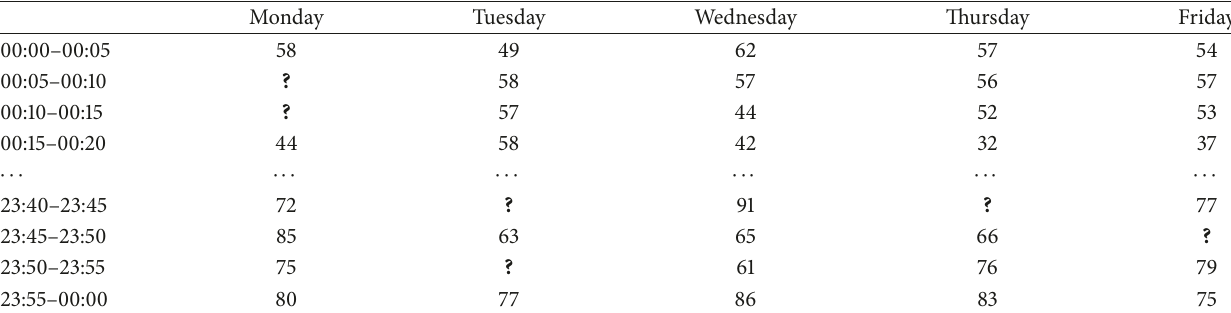
Table 2: A matrix-based missing data representation for “week